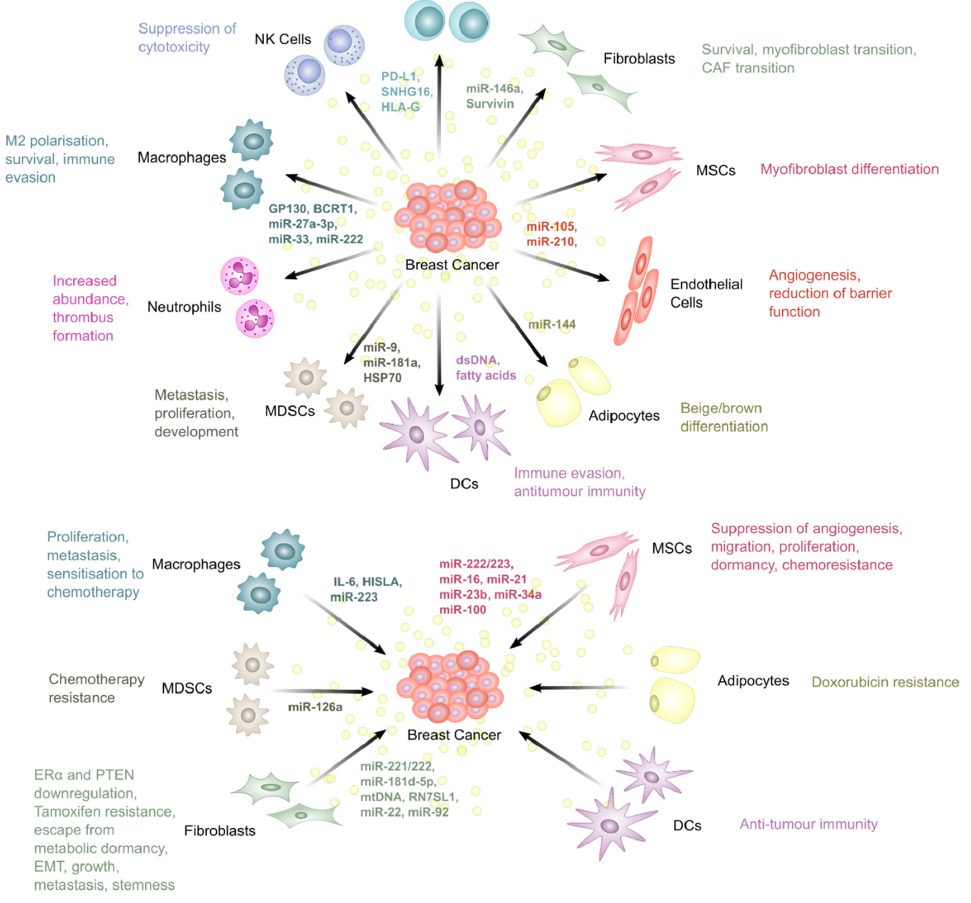
Figure 3. Bidirectional EV communication between BC and the TME. EVs from BC cells contain miRNA, DNA, lipid and protein cargo which is used to alter the behaviour of the TME, promoting therapy resistance. In turn, cells of the TME communicate via EVs which are taken up by BC cells to produce therapy resistance and more aggressive disease. (Abbreviations: BC, breast cancer; BCRT1, breast cancer related transcript 1; CAF, cancer-associated fibroblast; DC, dendritic cell; dsDNA, double-stranded DNA; EV, extracellular vesicle; GP130, glycoprotein 130; HISLA, HIF-1 α - stabilising long noncoding RNA; HLA-G, the human leukocyte antigen-G; HSP70, heat shock protein 70; IL-6, interleukin-6; MDSC, myeloid-derived suppressor cell; MSC, mesenchymal stem cell; NK, natural killer; PD-L1, programmed death-ligand 1; SNHG16, small nucleolar RNA host gene 16; TME, tumour microenvironment).